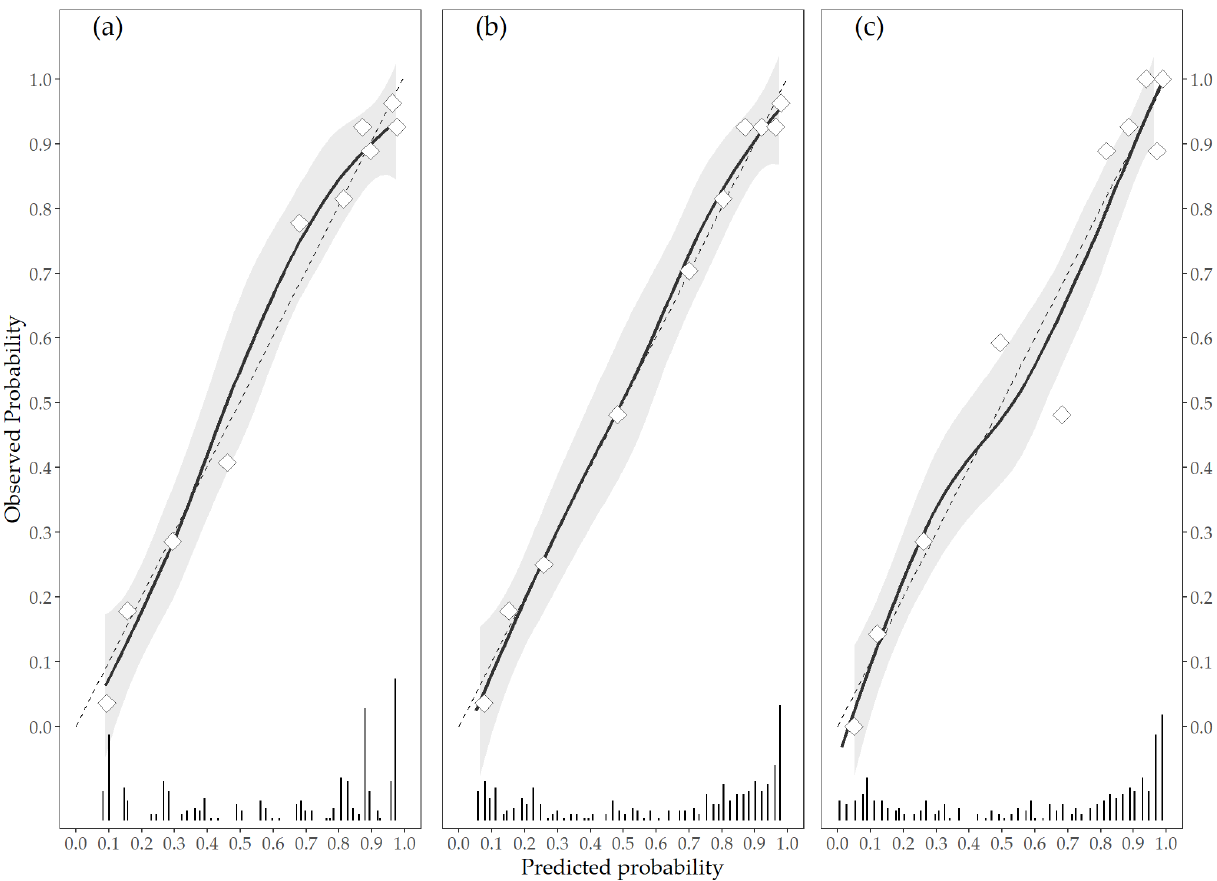
Figure 2. Calibration plots of predicted vs. observed probability in the Revision ( a ), Continuous ( b ), and Complete ( c ) models. The triangles represent deciles of subjects grouped by similar predicted risk; dashed line represents the linear calibration curve; solid line and grey area represent loess calibration curve and its standard error. The distribution of subjects by predicted probability is shown with bars at the bottom of the plot.